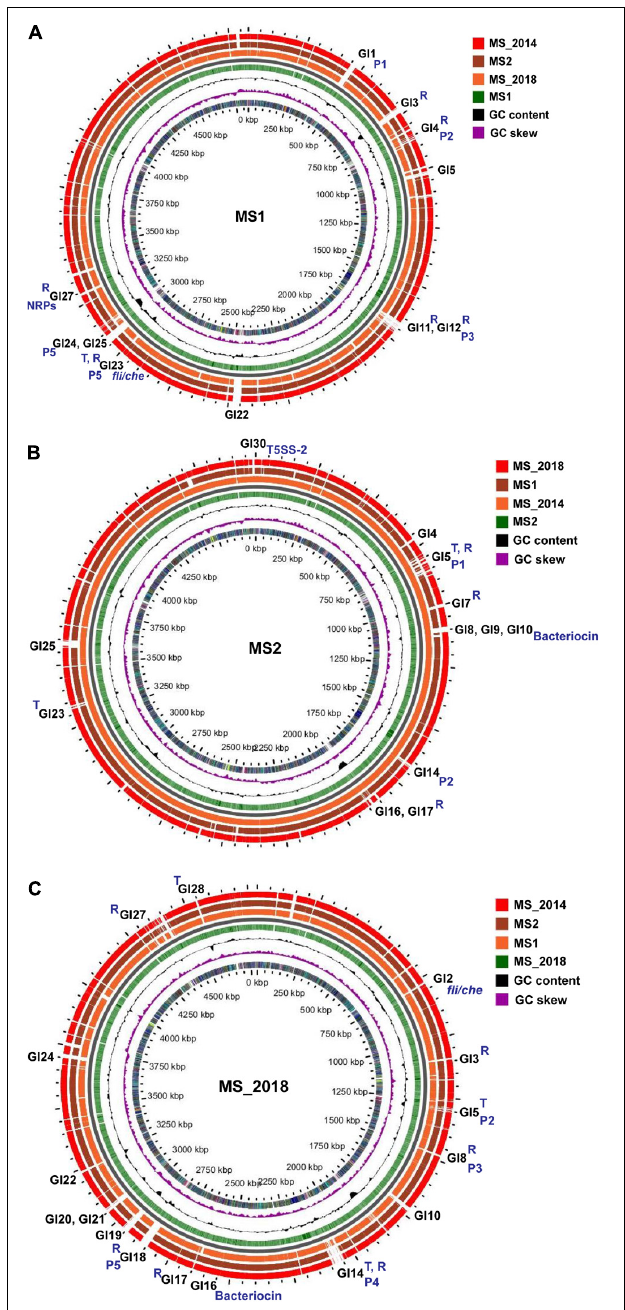
FIGURE 7 | Genome BLAST atlas of D . zeae strains isolated from banana. (A) Comparison using MS1 as the reference genome. (B) Comparison using MS2 as the reference genome. (C) Comparison using MS_2018 as the reference genome. In each map of genome BLAST atlas, circles from outside in, –3, –2, and –1, indicate the query genomes, 0 indicates the backbone, 1 indicates the reference genomes, 2 indicates GC Contents on the reference sequence, 3 indicates GC Skew on the reference sequences, and 4 indicates COG categories of CDS regions on the reference sequences. Regions containing transposons and repeats are marked with T and R, respectively; regions corresponding to genomic islands and prophages are marked with GIs and Ps, respectively; regions corresponding to fli / che , bacteriocin, and NPRs are also labeled